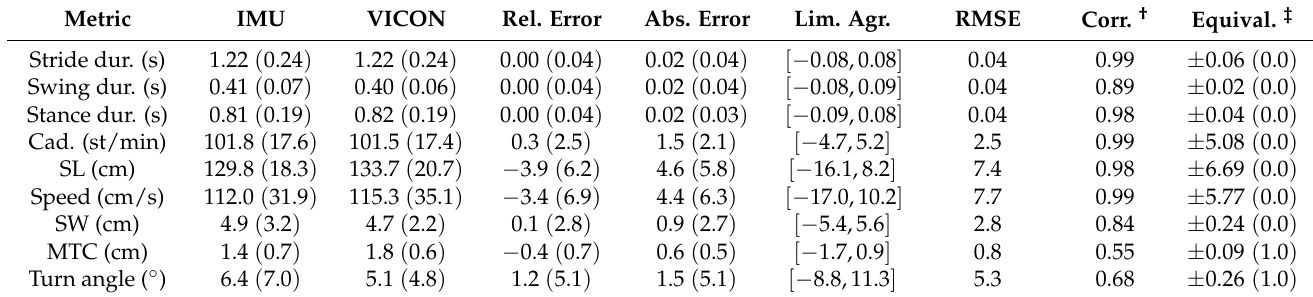
to be practically equivalent (with p < 0.01), except for MTC and turning angles. Average relative errors of 0.00 ± 0.04 s and − 3.9 ± 6.2 cm were obtained for stride duration and SL, respectively (Table 5). Table 5. Performance on the validation set, excluding turning strides ( n = 3785 strides). Shown are mean values (standard deviation), limits of agreement, RMSE, correlation and equivalence interval ( p -value). † All correlations were based on Spearman and have p < 0.01. ‡ Equivalence tests were based on Wilcoxon signed-rank test.